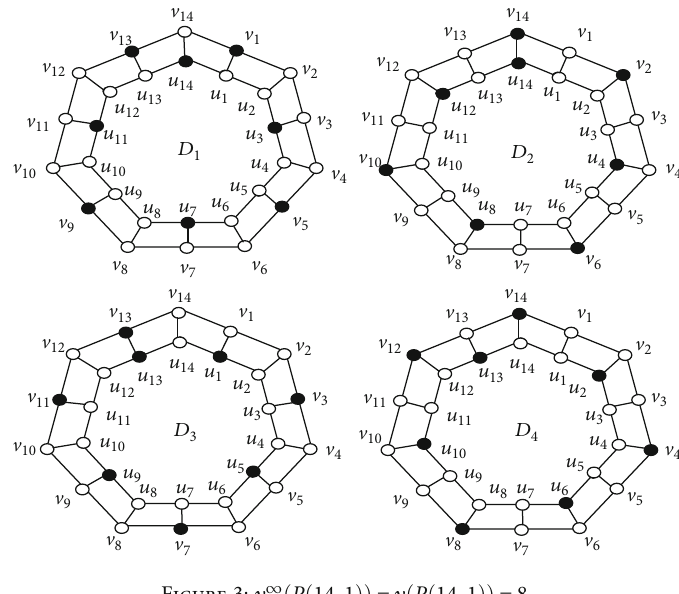
P ð 14, 1 ÞÞ = γ ð P ð 14, 1 ÞÞ = 8 . Figure 3: γ ∞ m ð